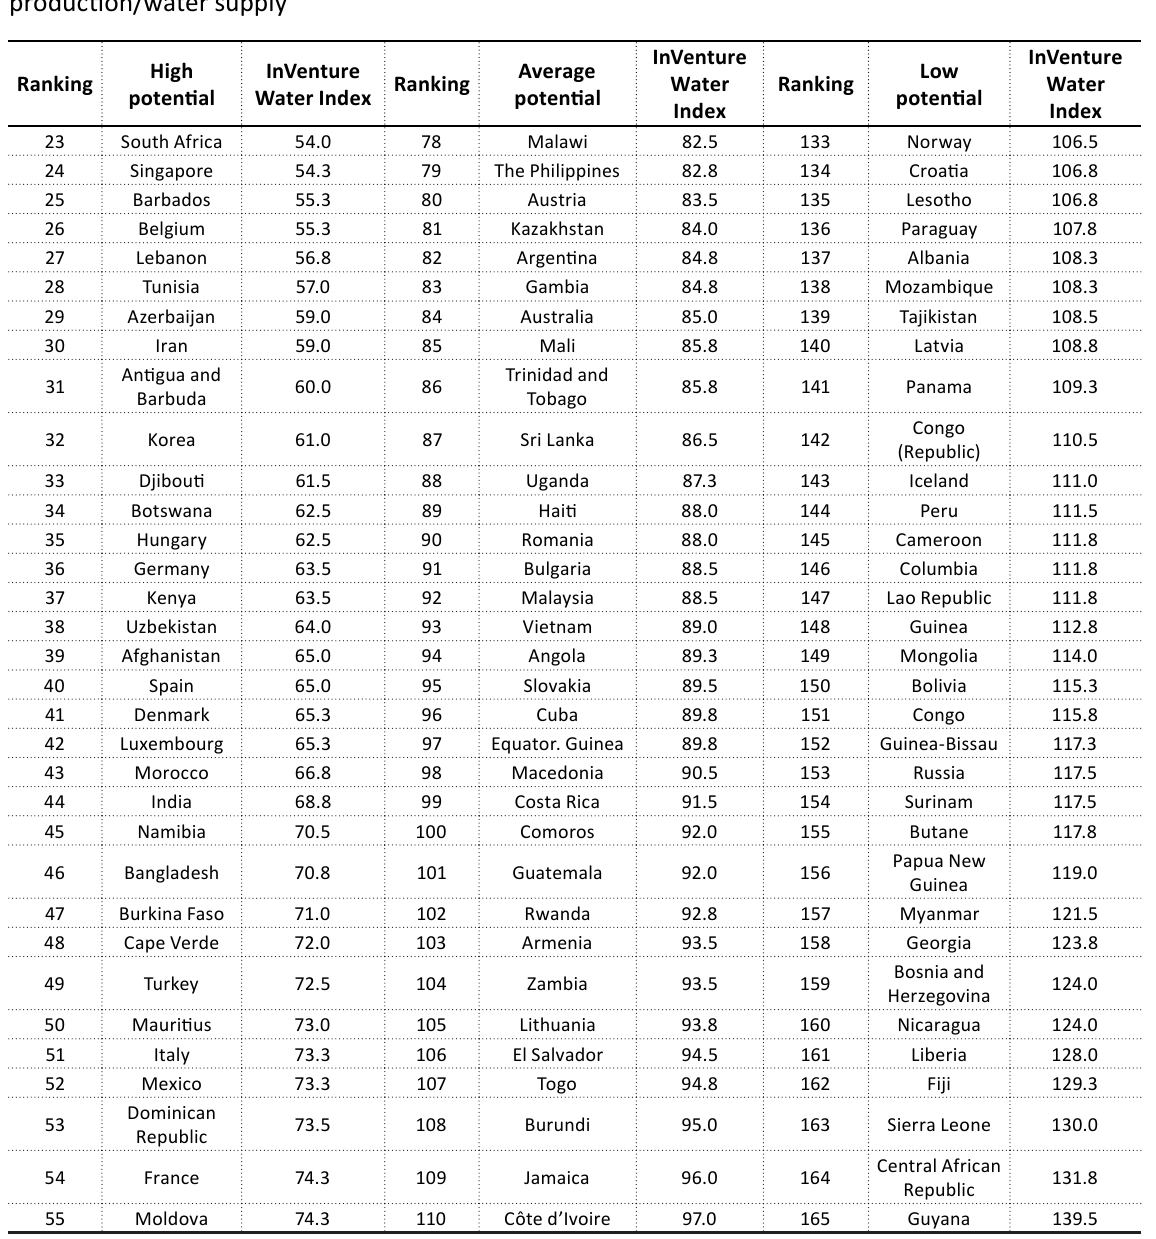
Table A3. The dynamics of the integrated territorial index of the efficiency of the water resources management system at the territorial level by the investment criterion,